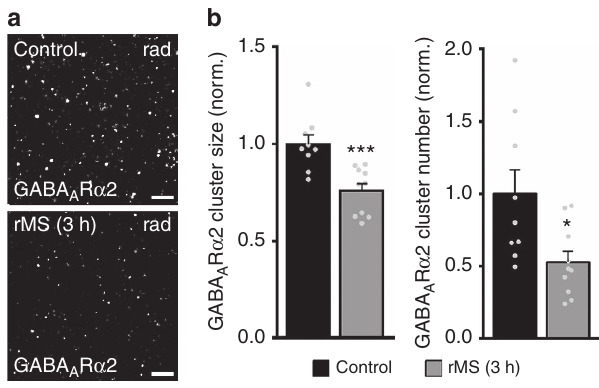
Figure 4 | rMS induces a reduction in GABA A receptor a 2